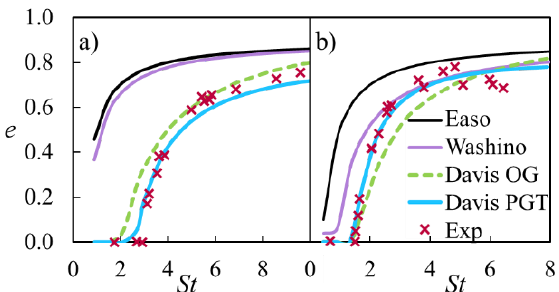
Fig. 4. Measured 𝑒 as a function of Stokes’ number for DEM models and experimental data for a) 3000cP viscosity oil and SS spheres b) 10000 cP viscosity oil and SS